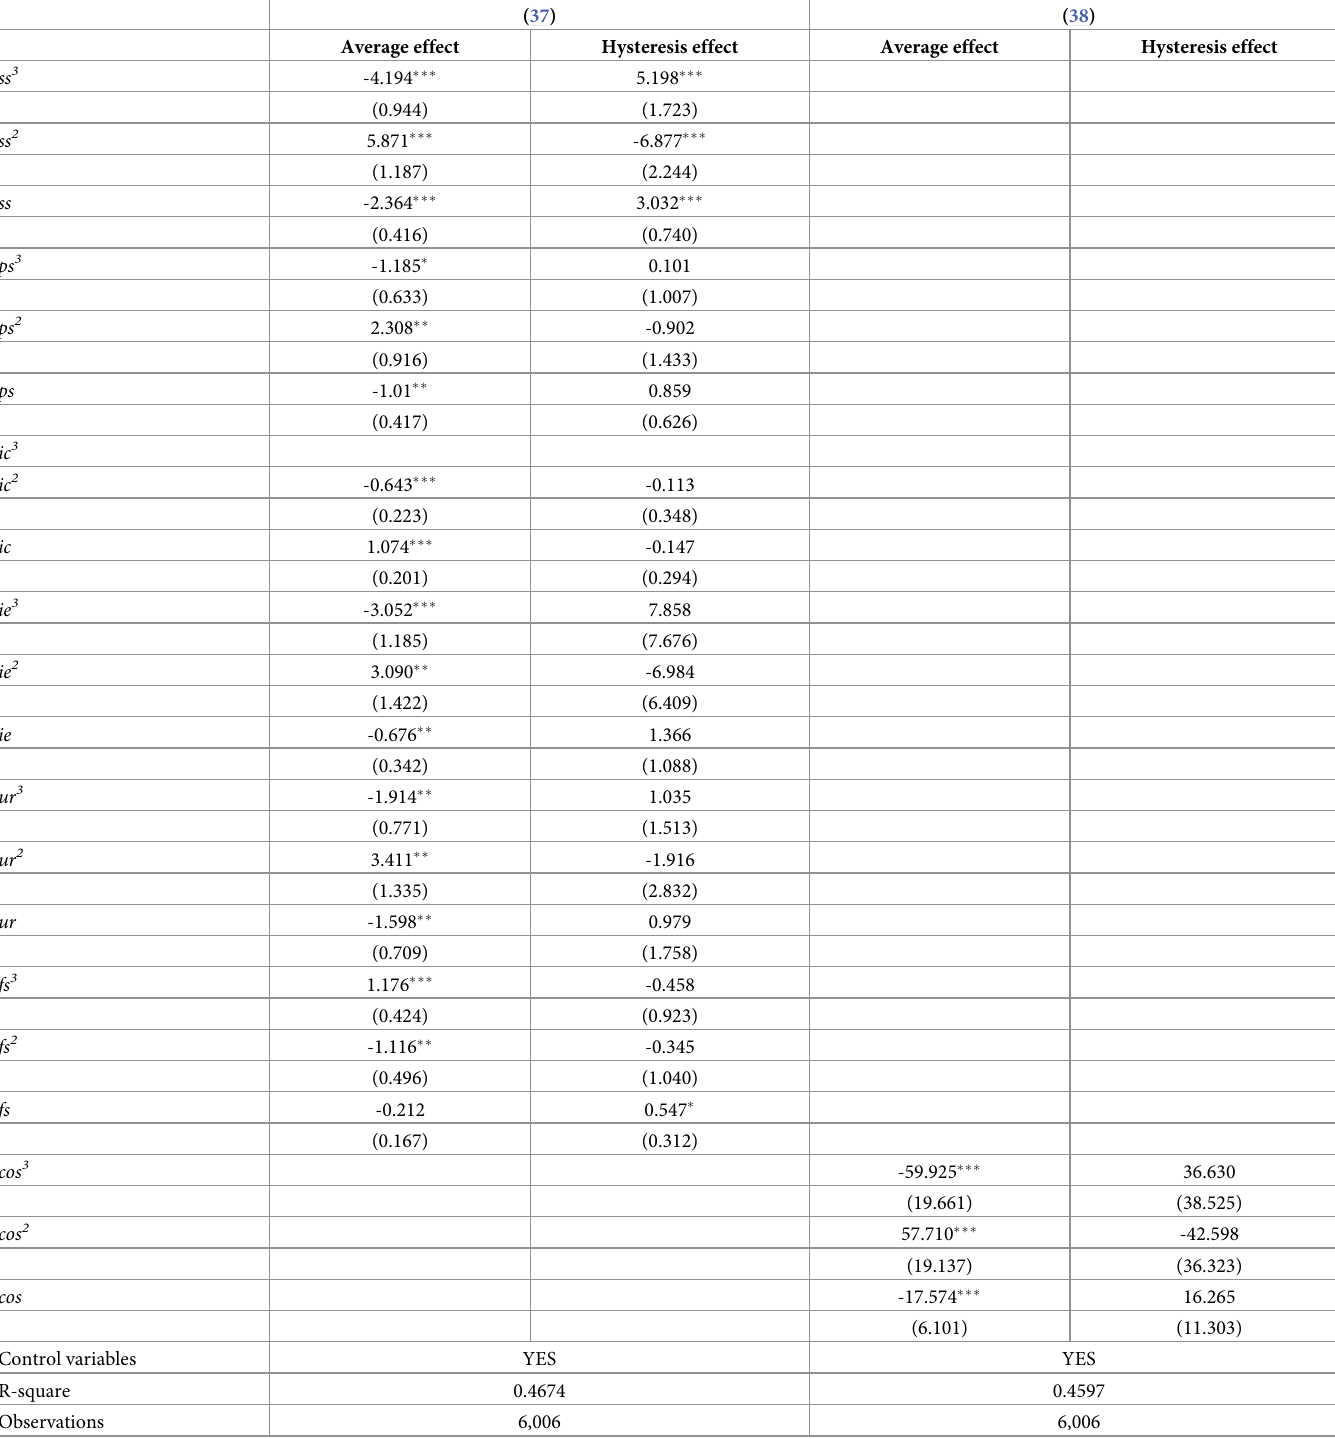
Table 7. SDM regression of Eqs (37) and (38) (dependent variable: lnrpgdp